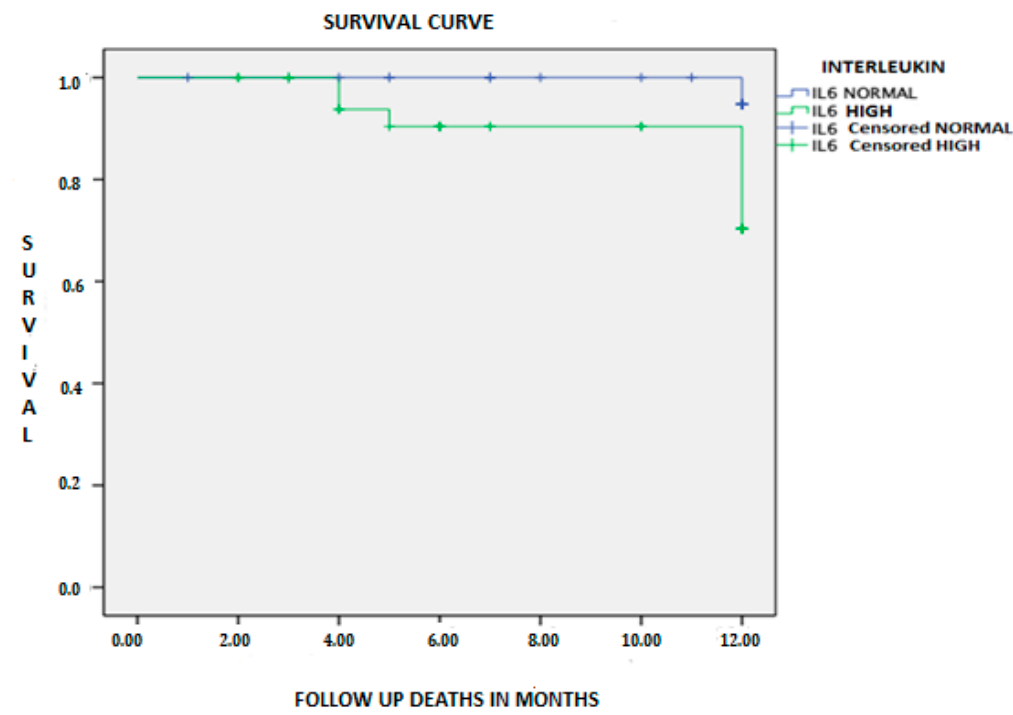
Figure 1. Kaplan–Meier survival curve of patients with heart failure in both groups according to interleukin-6 (IL-6)